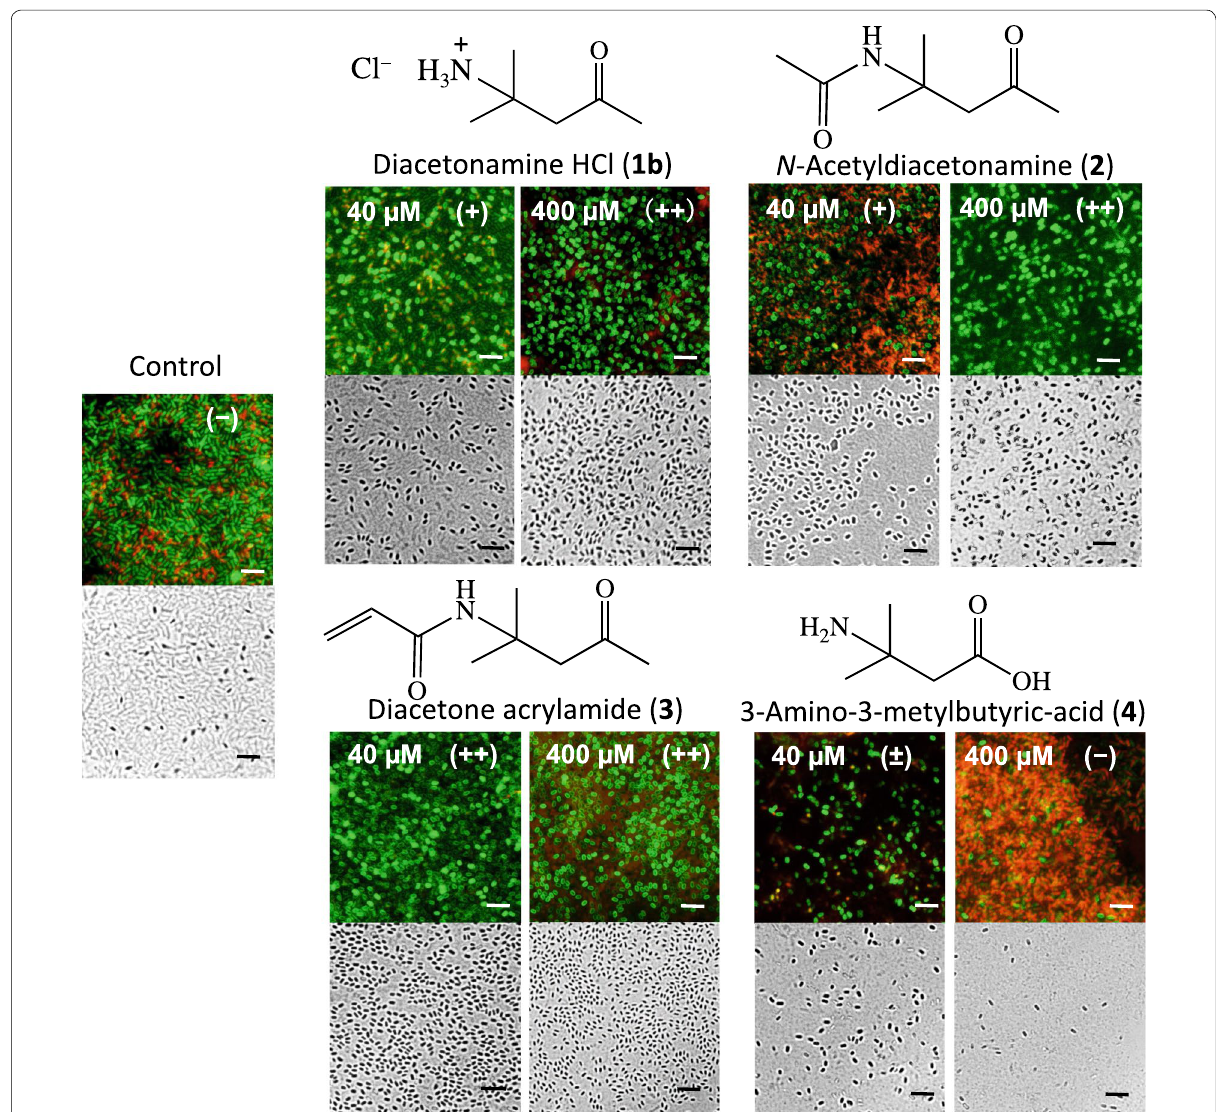
Fig. 3 Spore-inducing activity of diacetonamine and its amide derivatives toward B. amyloliquefaciens AHU 2170. Sporulation after the treatment with 40 and 400 µM is shown in microscopic photographs. Spores are apparent as short rods stainable as green by SYTO 9. Photo-images are after 48-h incubation upon exposure to the test compounds in MSG medium under a fluorescent microscope. Sporulation frequency was defined as ( ambiguously positive as less than 10% sporulation from all the vegetative cells; ( >50% sporulation. Scale bar 5 =